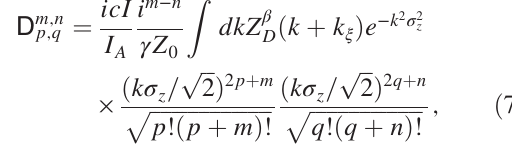
r n= 2 e − r ffiffiffiffiffiffiffiffiffiffiffiffiffiffiffiffiffiffiffiffiffiffiffi